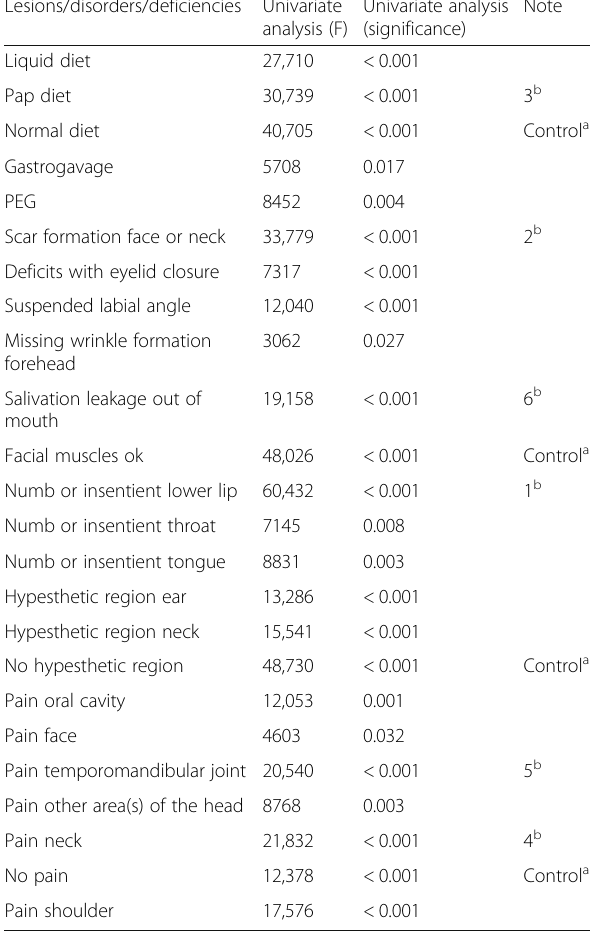
Table 8 Medical lesions/disorders/deficiencies, mentioned by the patient and further medical data of the questionnaire calculated using Kruskal-Wallis and univariate ANOVA Lesions/disorders/deficiencies Univariate Univariate analysis analysis (F)